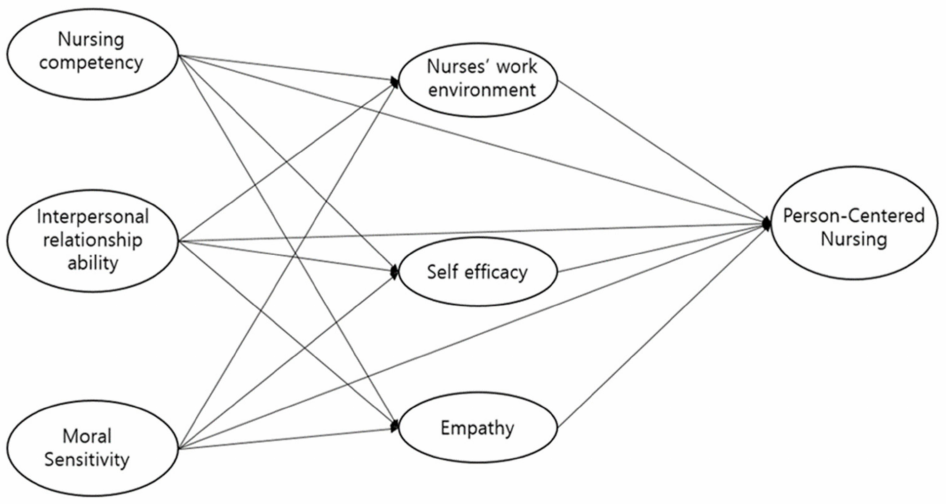
Figure 1. Hypothetical